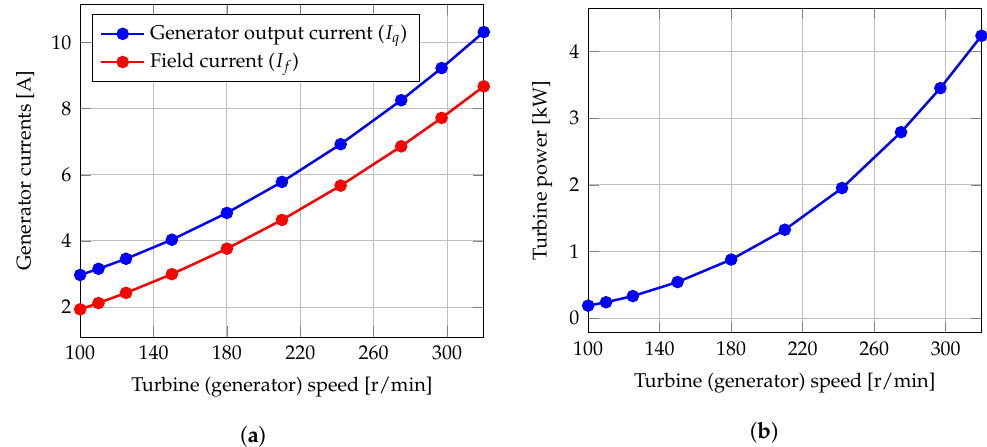
Figure 8. FEA ( a ) optimal generator output current ( I q )( I d = 0 ) and rotor field current ( I f ) for MPPT at minimized copper losses of the WRSG, and ( b ) turbine MPP curve as a function of the generator speed.